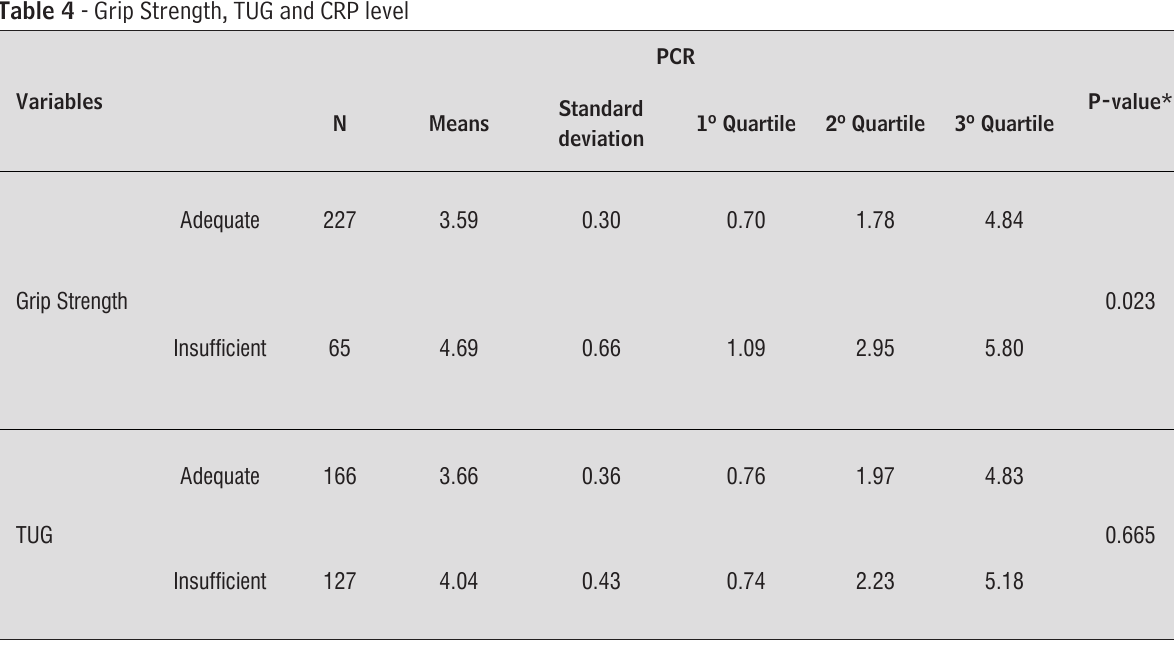
Table 4 - Grip Strength, TUG and CRP level